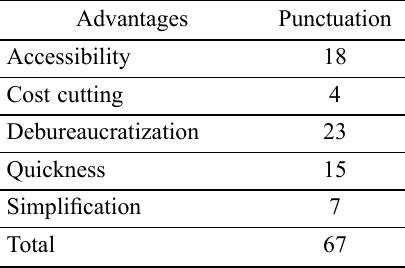
Table 9. Main advantages of using